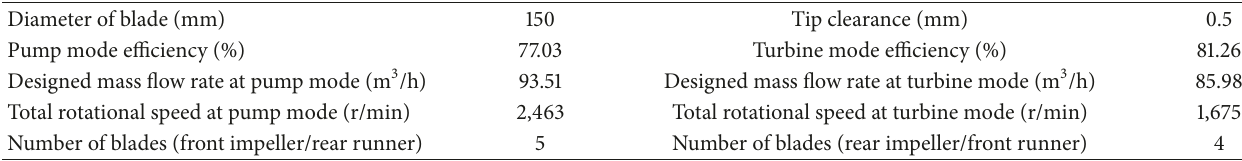
Table 1: Design specifications of the reference design.